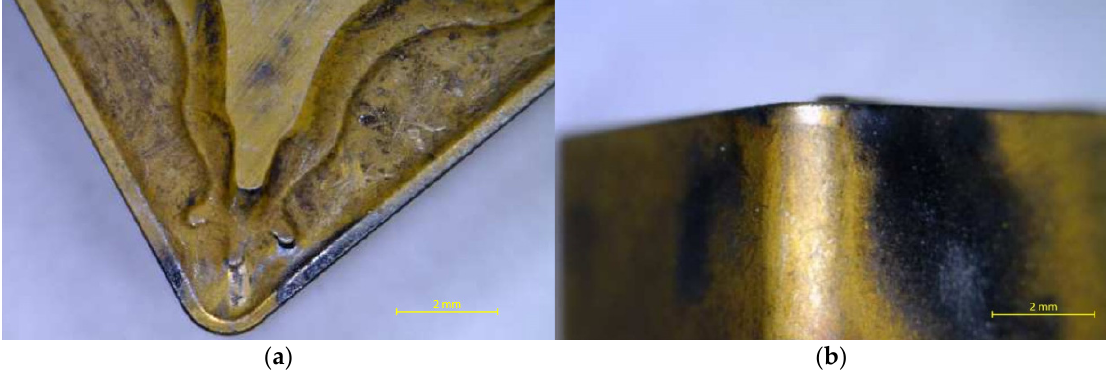
Figure 9. Cutting edges after machining of the annealed samples. ( a ) influenced face of the insert; ( b ) major and minor flank influences on the insert.